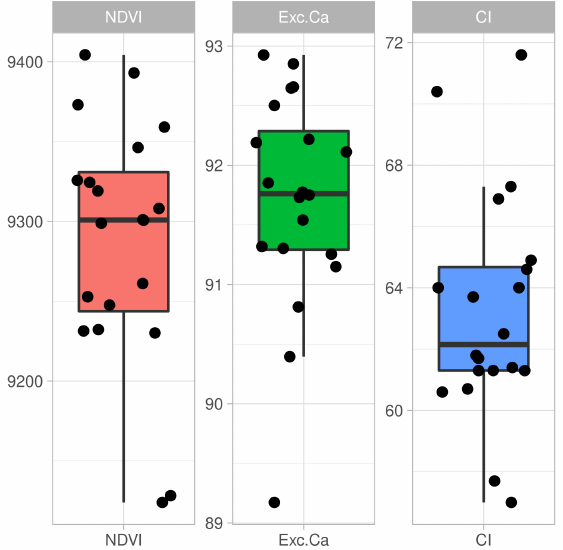
Figure 6. Data distribution (jittered dots) and boxplot of the predictive model variable (NDVI) and explanatory variables. See Table 1 for